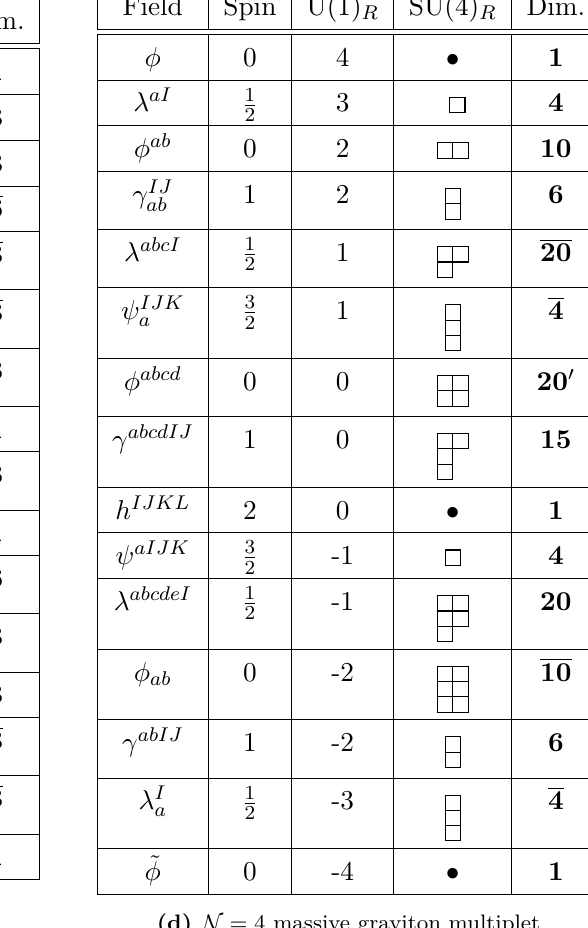
Table 1. On-shell content of massive graviton multiplets with N ≤ 4 supersymmetry. States are labelled with capital Latin indices I, J, . . . corresponding to SU(2) LG and lowercase Latin indices a, b, . . . corresponding to SU( N ) R . The last and second-to-last columns give the dimension and Young tableaux respectively of the SU( N ) R representations in the conventions of [62,